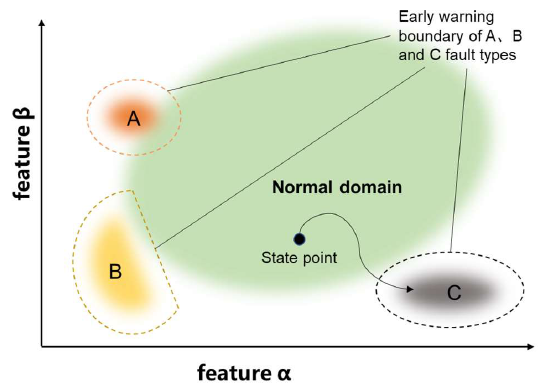
Figure 2. Spatial distribution of engine